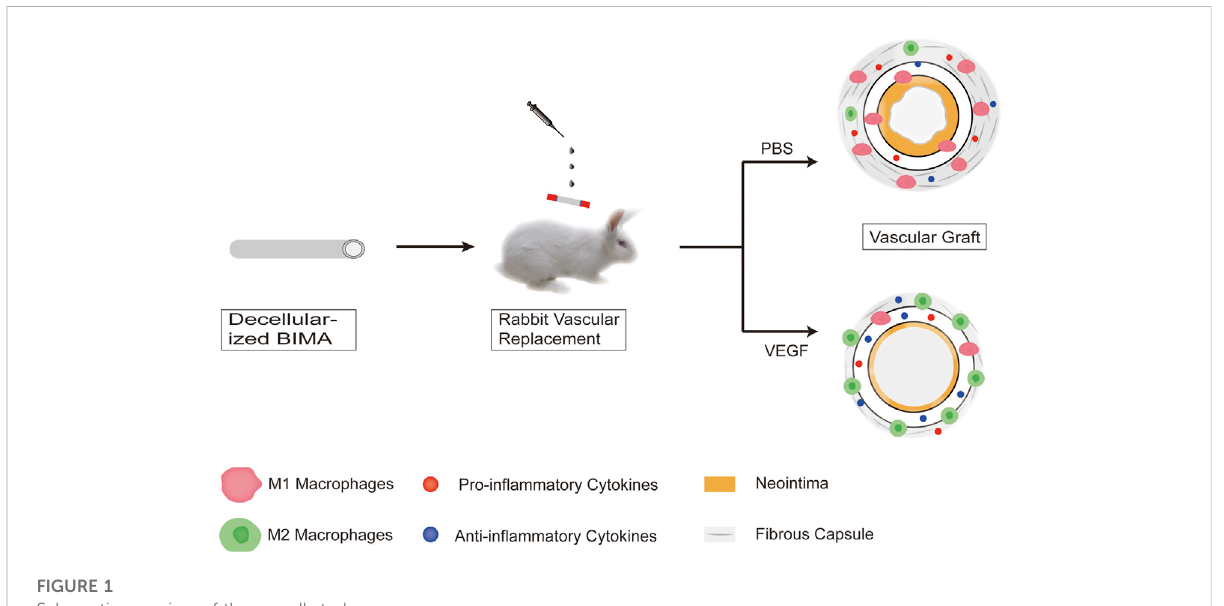
FIGURE 1 Schematic overview of the overall